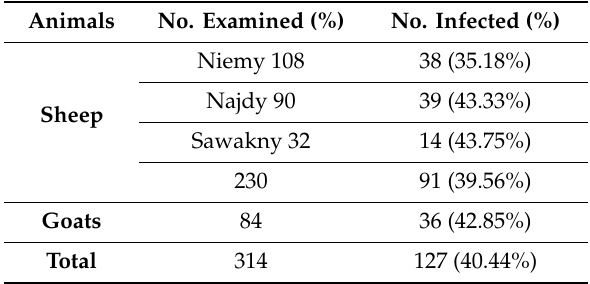
Table 2. Prevalence of Sarcocystis species in sheep and goats. Animals No. Examined (%) No. Infected (%) Niemy 108 38 (35.18%) Najdy 90 39 (43.33%) Sheep Sawakny 32 14 (43.75%) 230 91 (39.56%) Goats 84 36 (42.85%) Total 314 127 (40.44%)